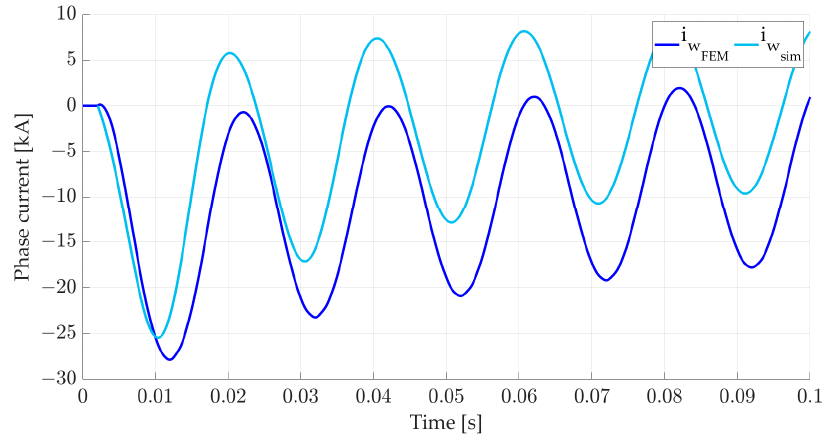
Figure 17. The comparison of phase current “w” obtained by the FEM calculation and by the dynamic model.